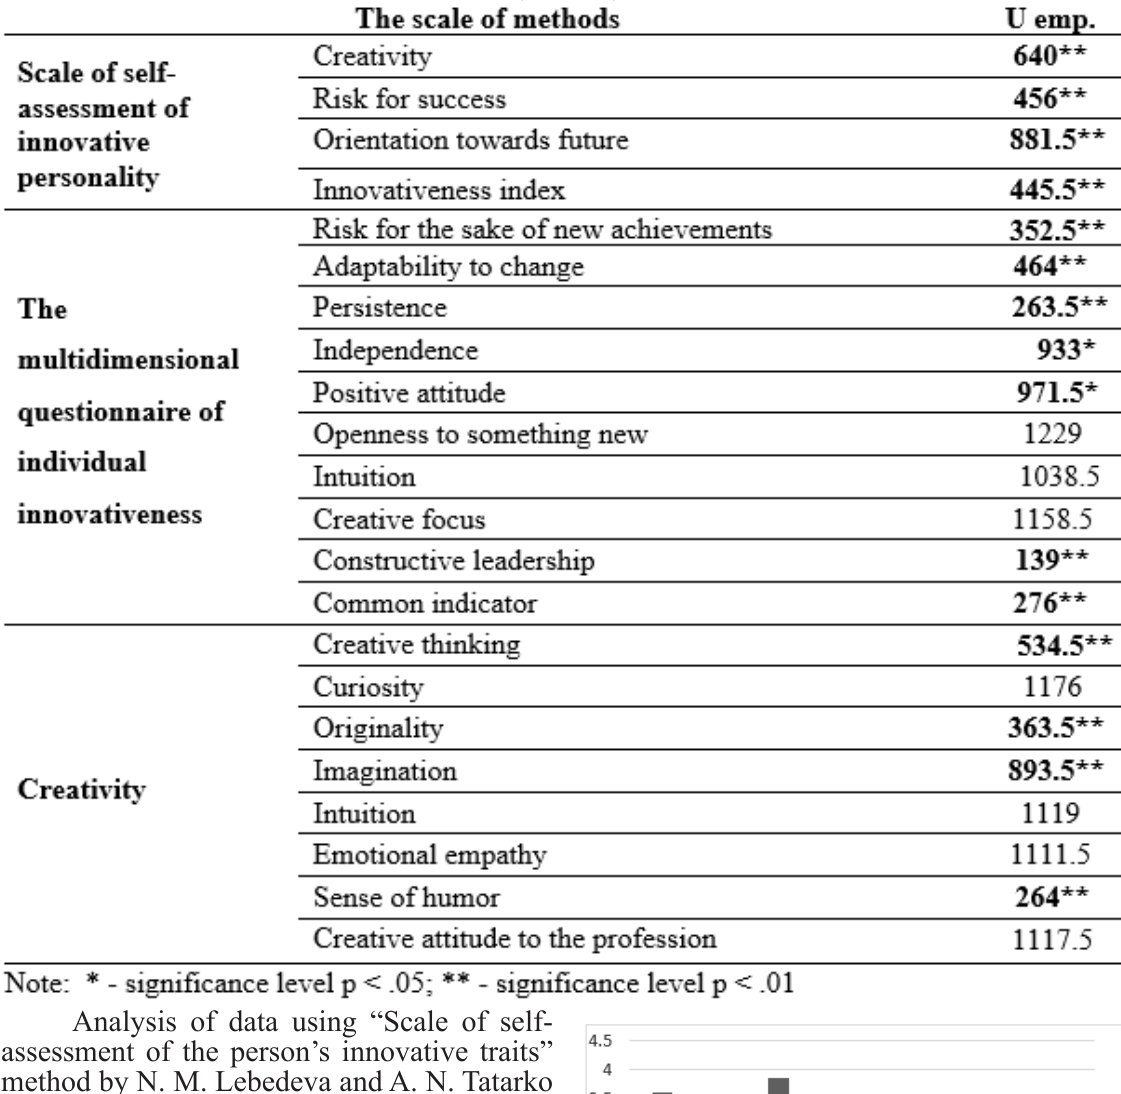
Table 1. Results of comparative analysis of differences in all methods in the two